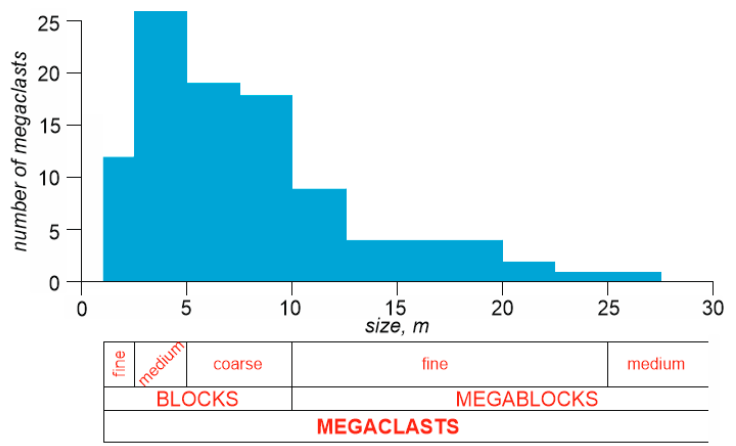
Figure 10. Grain-size distribution of megaclasts on the western plot of the Hondarribia locality.